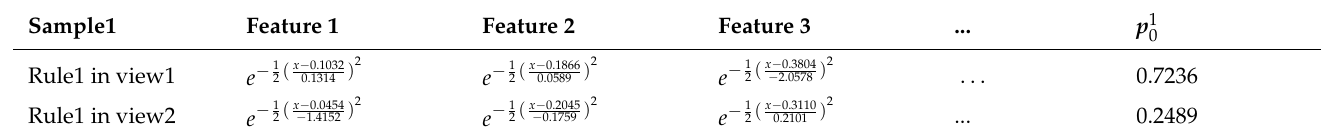
Table 5. Antecedent and consequent parameters and the Gaussian membership function.